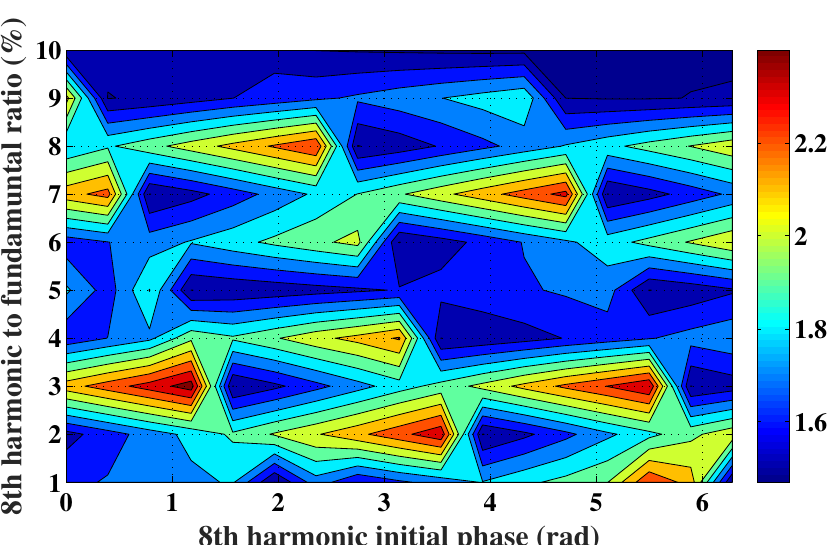
Figure 14. Mapping of the ripple of the total torque developed following the injection of an harmonic current of rank 8, plotted in the same plane as Figure 13.